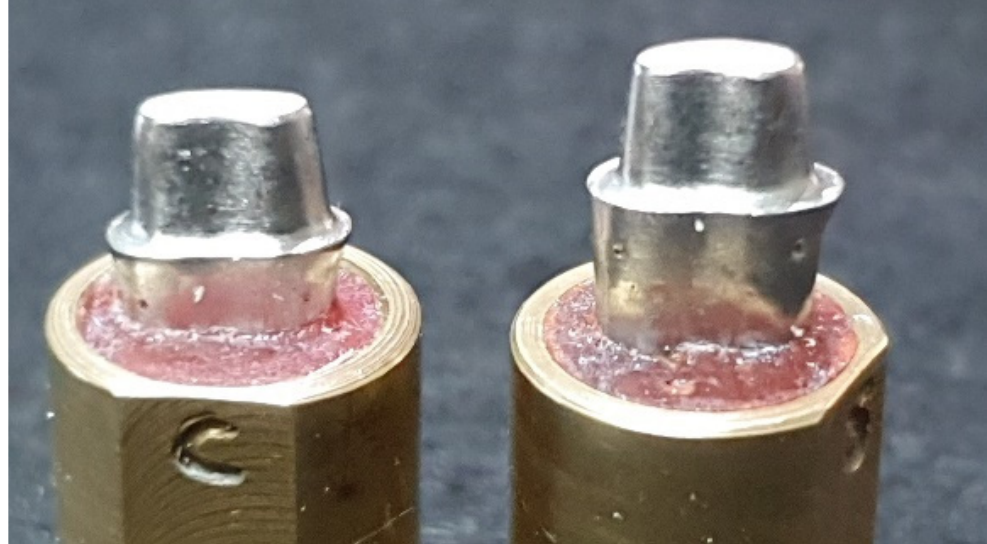
Figure 1. Master metal dies: chamfer and shoulder (left to right).